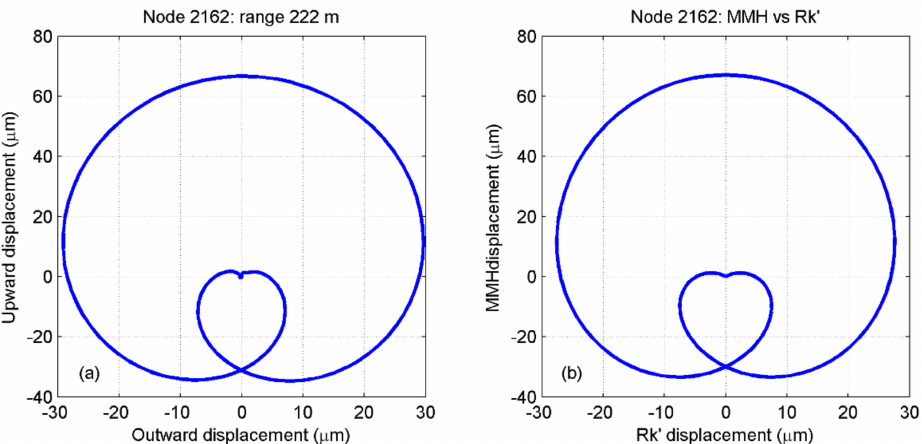
Figure 13. The FE data ( plot a ) is compared with the Rk (cid:48) mathematics ( plot b ) using hodographs.